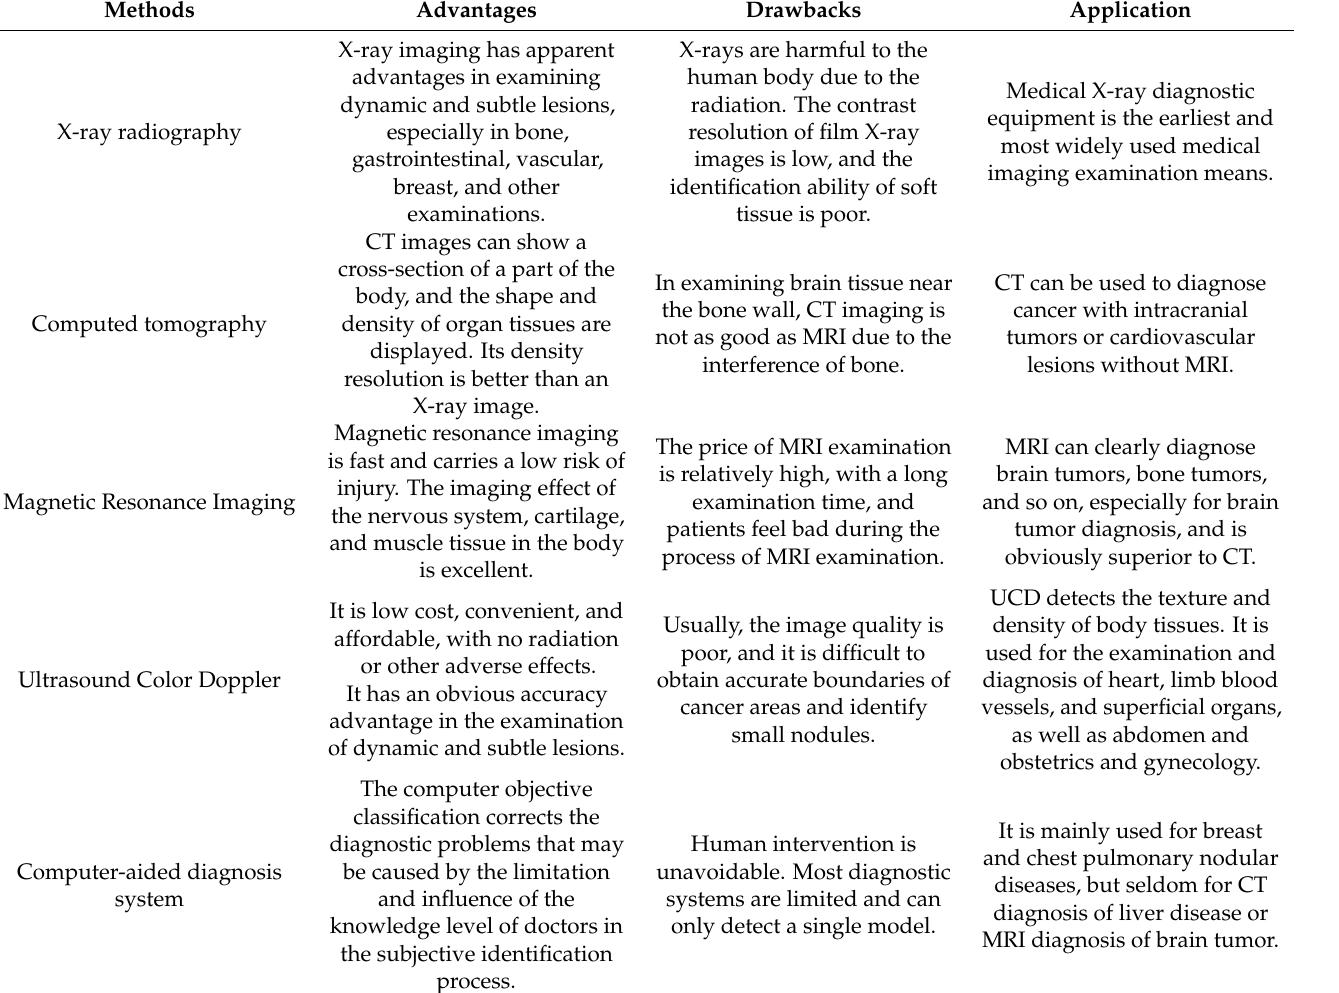
Table 1. A list of imaging examination methods commonly used in clinical